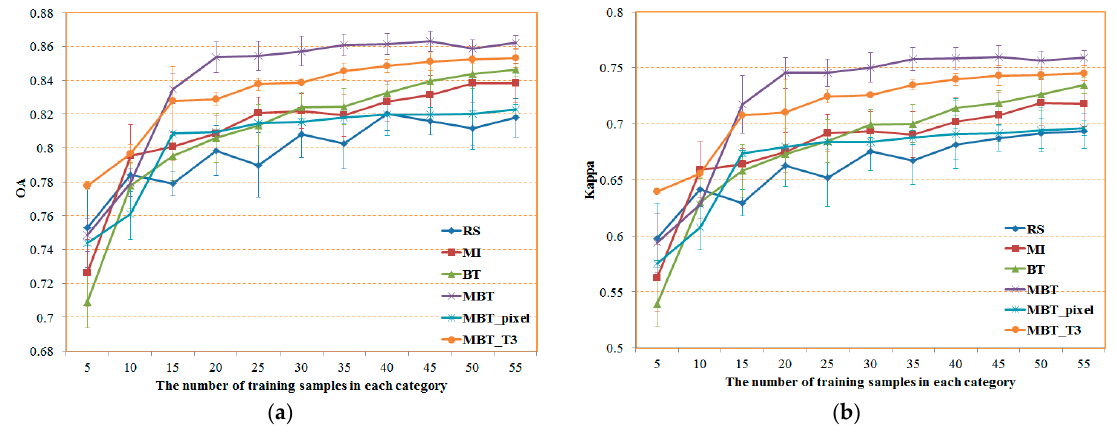
Figure 16. OA and Kappa curves with different numbers of training samples from the different strategies: ( a ) OA; ( b ) Kappa.